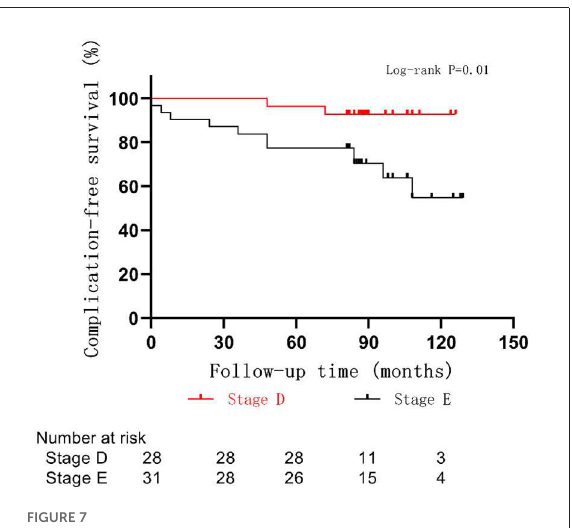
FIGURE5 Rate of complications by orbital implant size in 59 children with RB optic nerve invasion.